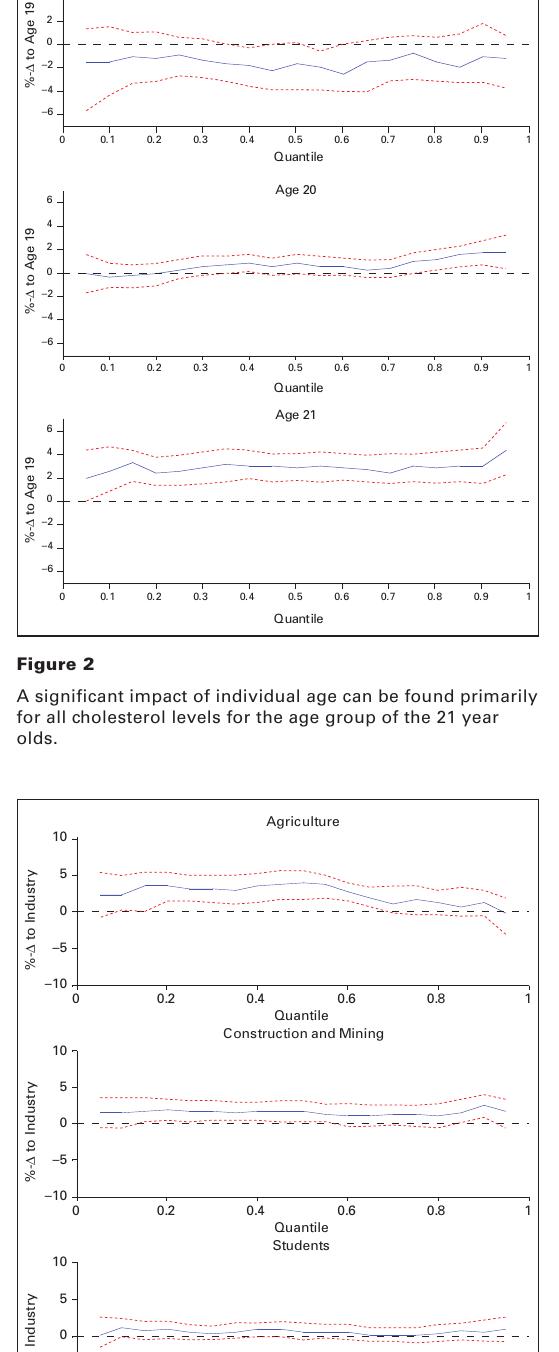
Factors influencing individual total cho- lesterol levels in Swiss male con- scripts (solid line: es- timated parameter, dotted lines: 95% bootstrap confidence interval; dashed horizontal line: zero response).